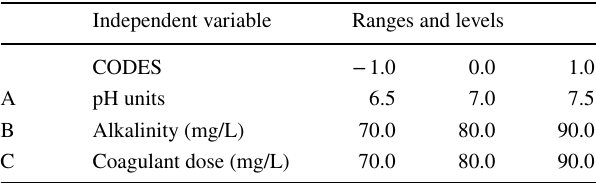
Table 2 Experimental coagulation condition (independent variable factors) ranges and levels